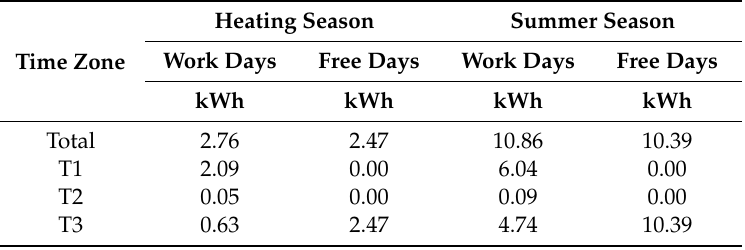
Table 3. The average daily exported energy in the summer and heating season for work days and free days.